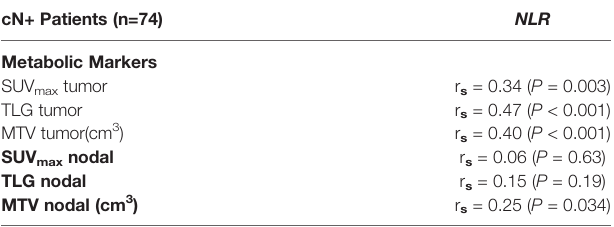
TABLE 2 | Correlation analysis. cN+ Patients (n=74) NLR Metabolic Markers SUV max